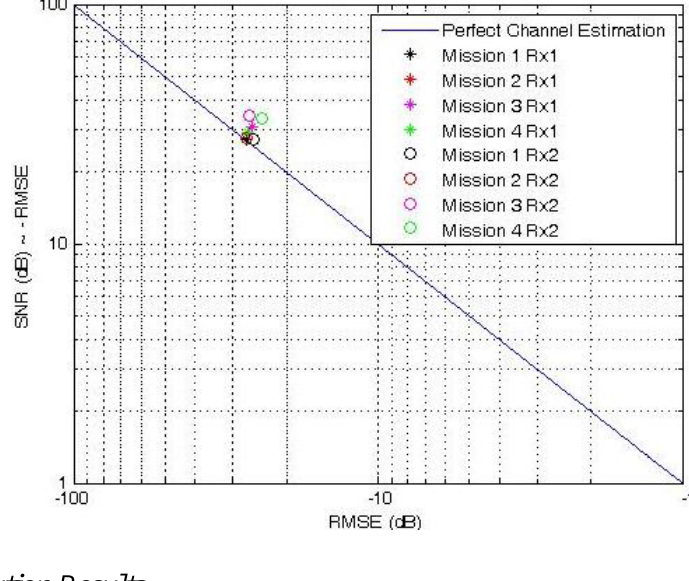
(dB) at the output of the channel CE